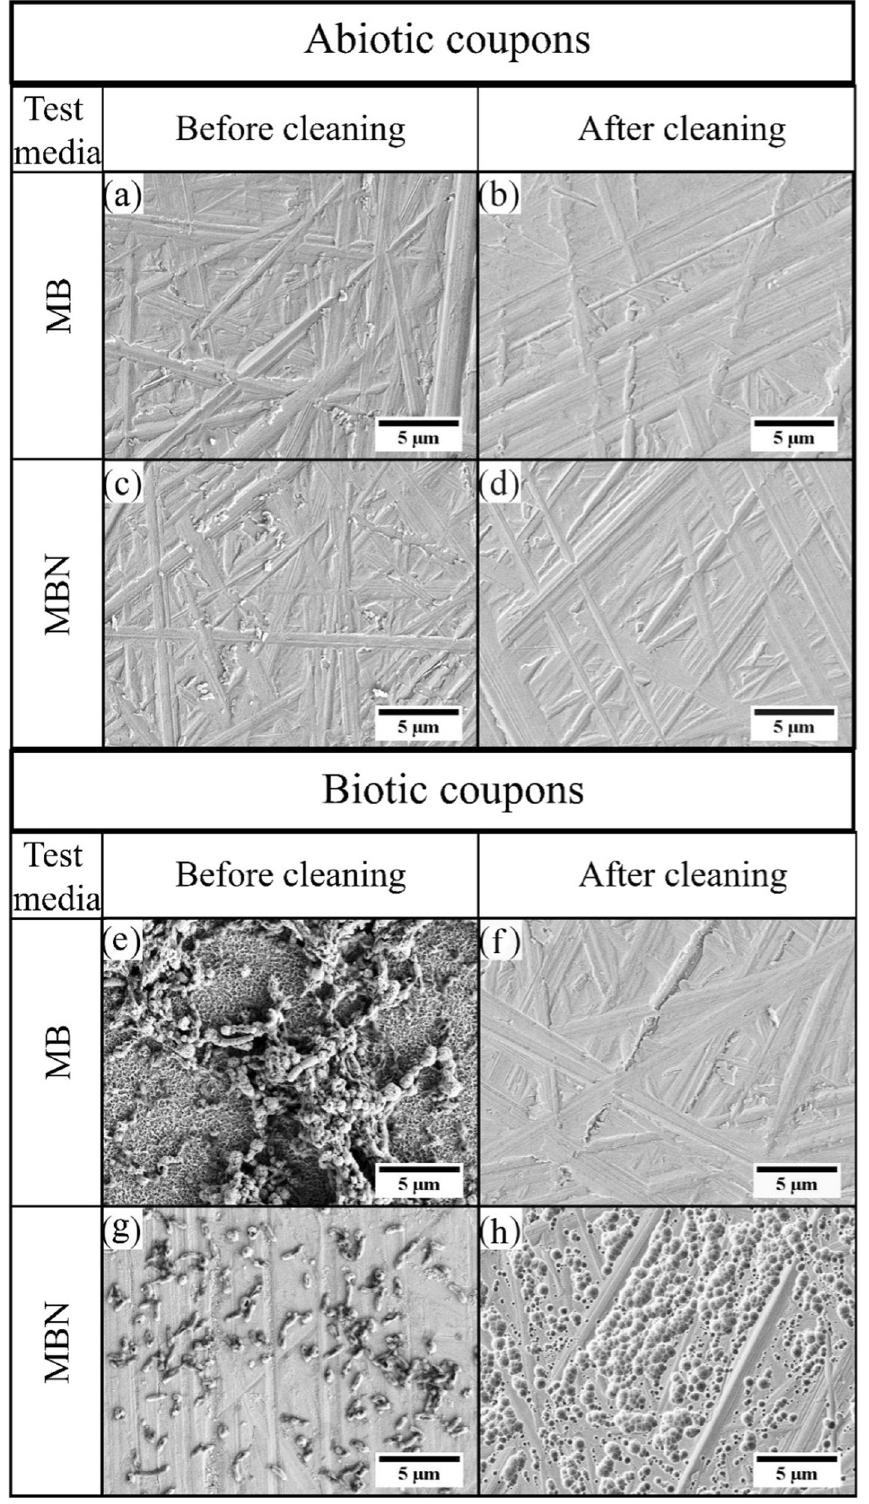
Fig. 2 SEM images of coupons immersed in different test media. SEM images of the 304 stainless steel coupons before and after removal of bio fi lm/corrosion products exposed to MB and MBN media for 32 days under abiotic and biotic would be expected for the localized type of corrosion observed, y − 1 after 32 days of exposure in the abiotic and biotic MB medium, the average corrosion rates of the coupons were found to be respectively. In contrast, a signi fi cant difference ( p < 0.05) was signi fi cantly higher in the biotic MBN medium (0.23 ± 0.02 µm y − 1 ) found in the corrosion rates of the coupons exposed to the abiotic and biotic MBN medium. While the rates are still relatively low, as